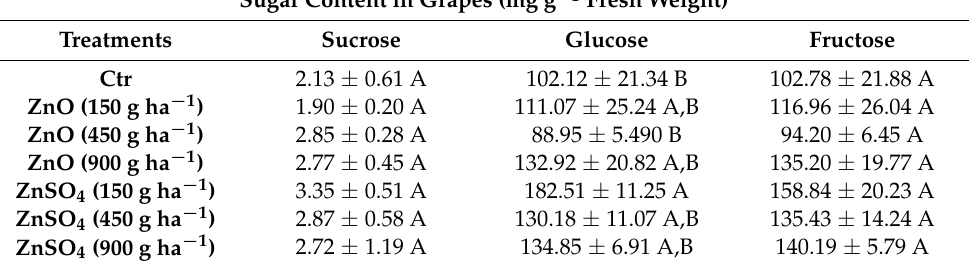
Table 3. Mean values ± SE (n = 3) of sugar content in grapes of Vitis vinifera variety Fern ã o Pires at harvest. Letters A and B indicate significant differences (statistical analysis using the single-factor ANOVA test, p ≤ 0.05).